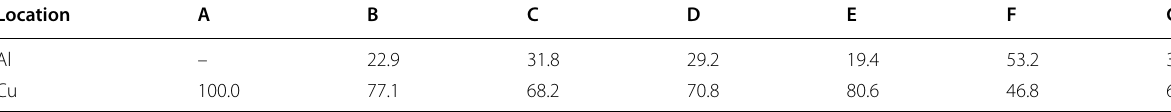
Table 4 EDX quantification results (wt%) indicated in Figure 11a Location